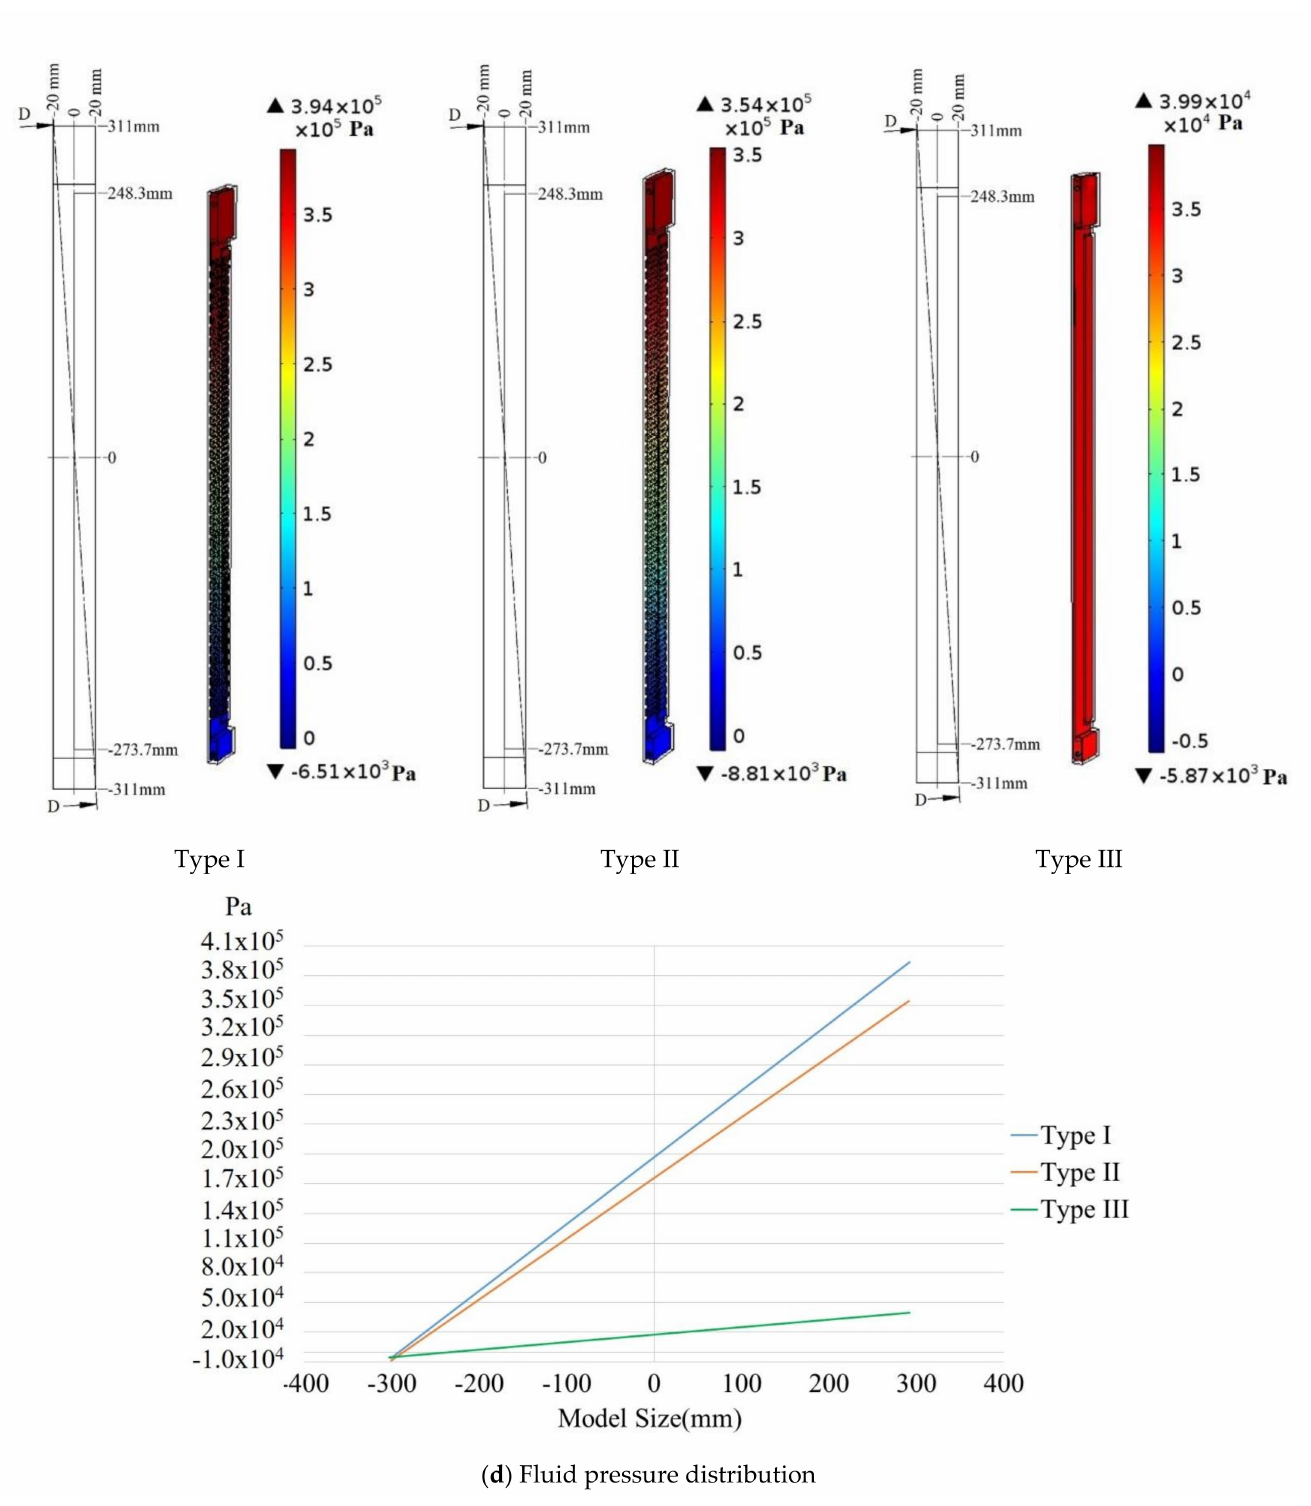
Figure 8. Simulation results of the fluid cold